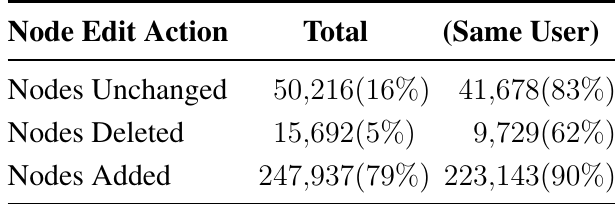
Summary of the number of consecutive versions where nodes were added, deleted, or left unchanged. The percentages in brackets indicate the number of cases where consecutive versions were edited by the same